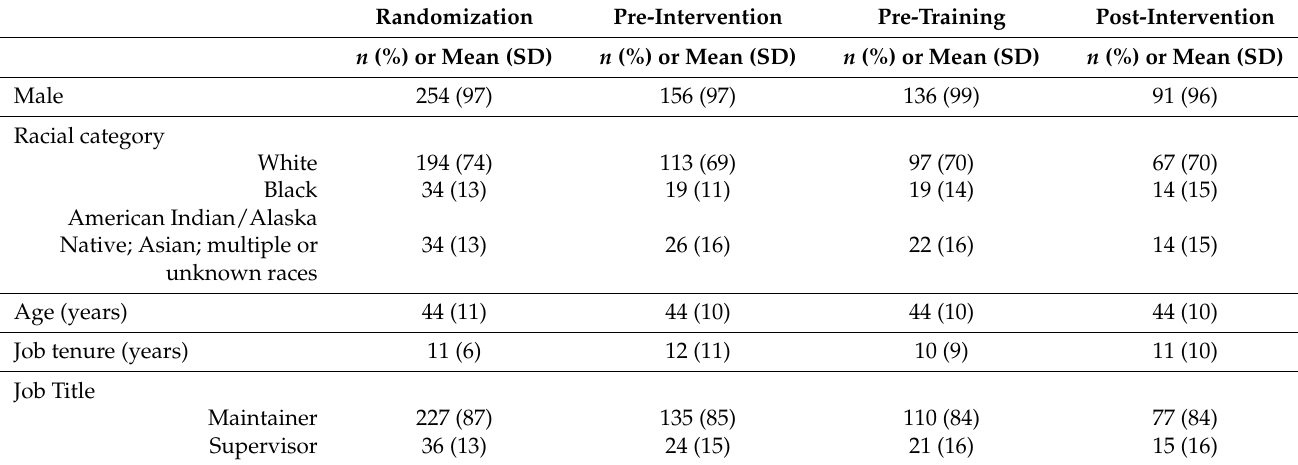
Table 3. Population characteristics across survey periods at 12 Department of Transportation garages: Data from worker surveys. Randomization